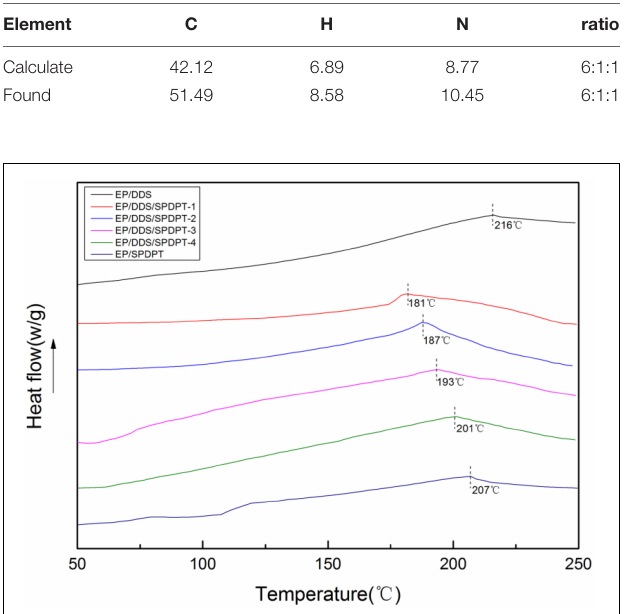
FIGURE 5 | DSC curves of epoxy